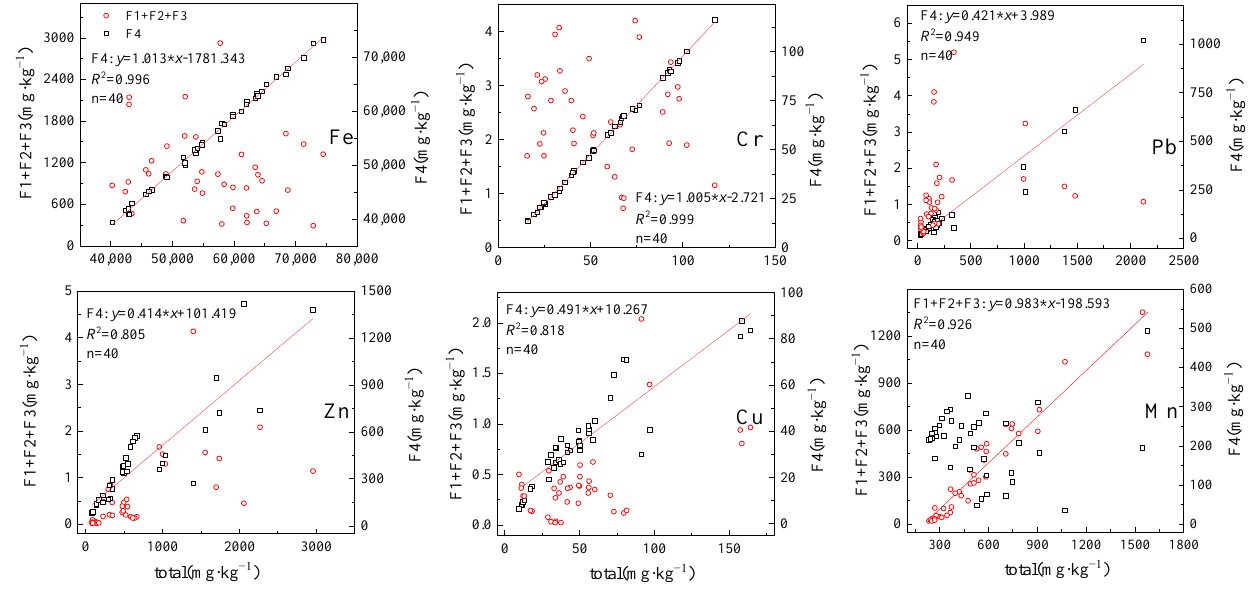
Figure 4. The linear relationship between the total amount of HMs and the extractable and residual fractions. (Note: the red dot in the figure represents the sum of F1+F2+F3; the small black square represents the value of F4).